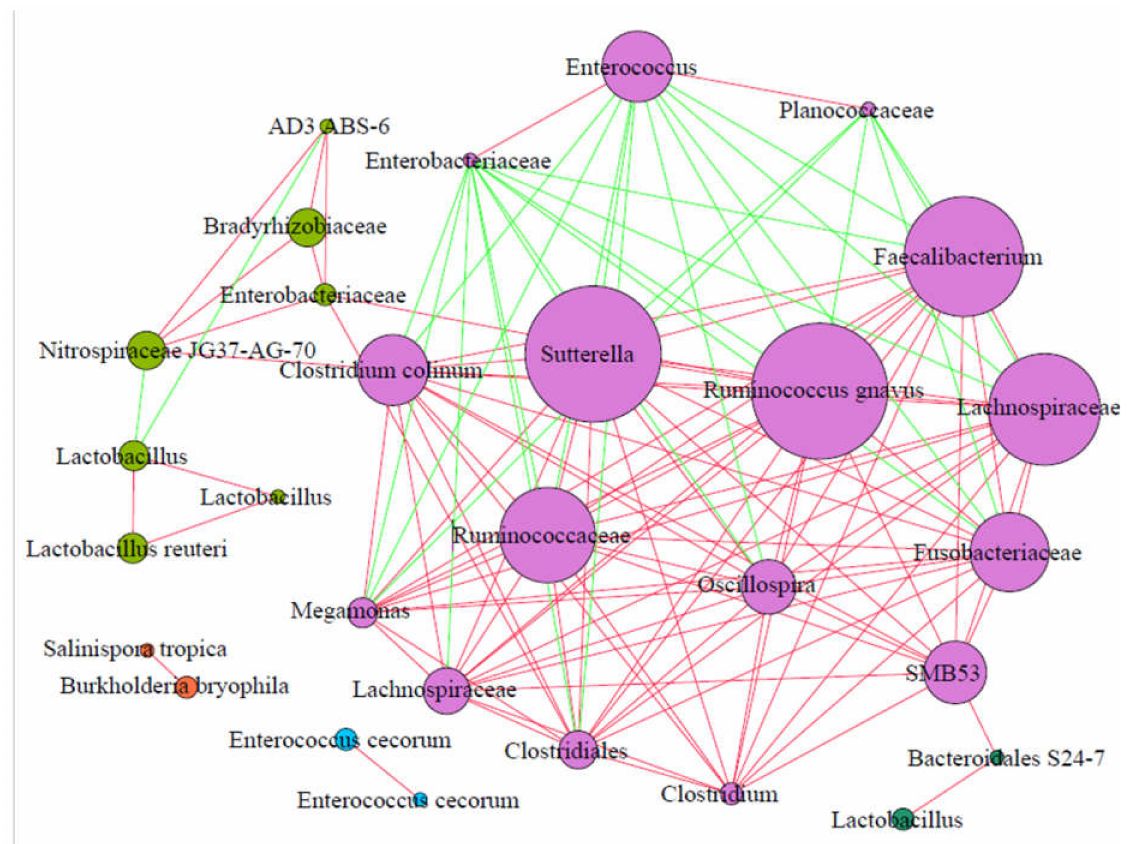
Figure 7. Interaction network of co-occurring important genera within feces bacteria in laying hens ( n = 86). The node represents the predominant genera in laying hens’ feces, the size of each node represents the relative abundance, and the nodes are colored based on module structure. The edges represent negative (red) or positive (green) correlations of two connected